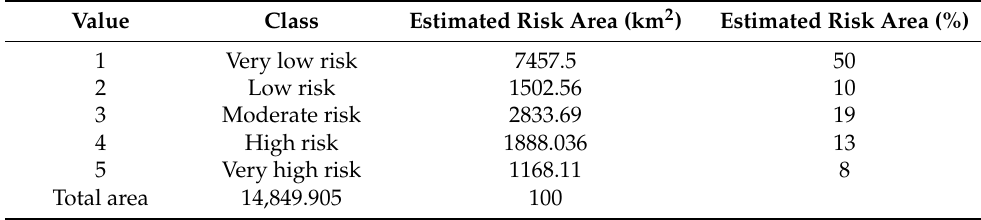
Figure 6. Flood risk zones map of the study area using the FP and AHP models. Table 4. Flood susceptibility risk classes and estimated area in square kilometers and